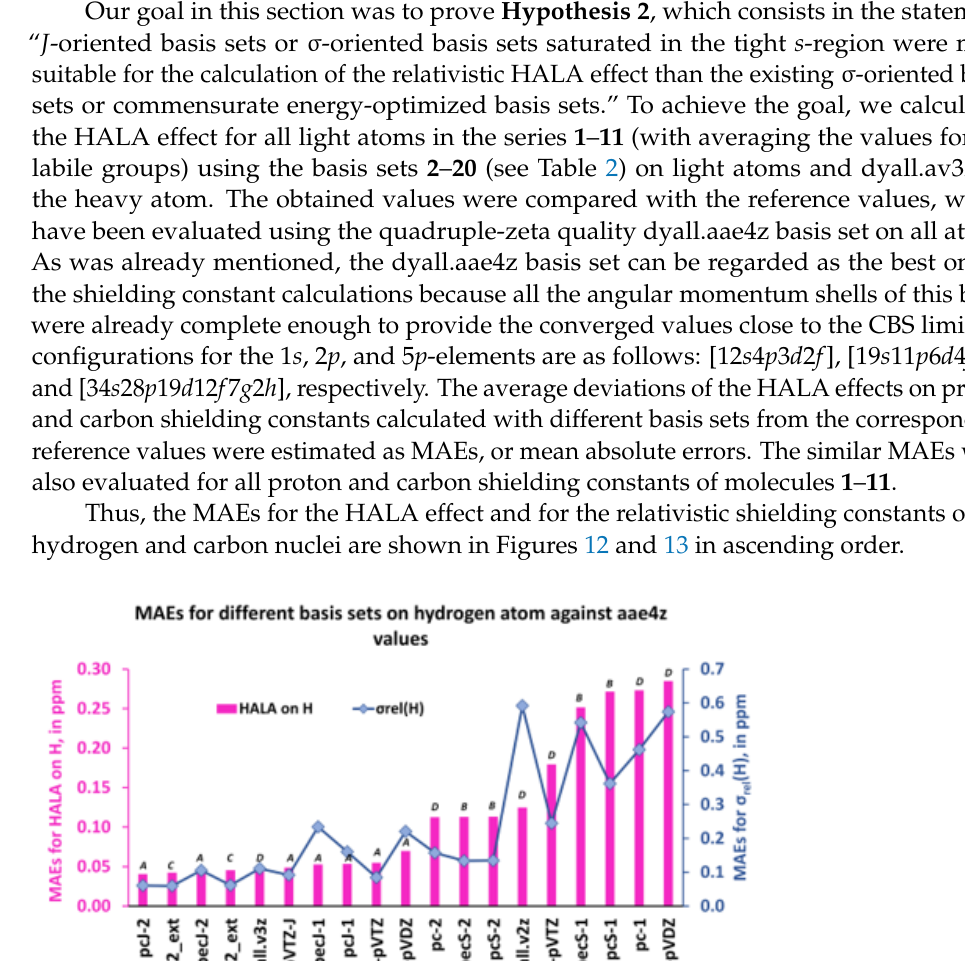
Figure 13. The MAEs for the HALA effect on the carbon shielding constants and that of the carbon shielding constants of molecules 1 – 11 were calculated with different basis sets on light atoms against the values obtained with the dyall.aae4z basis set on all atoms. As one can see from Figures 12 and 13, the first five least MAEs for both the HALA effect and the shielding constants of carbon and hydrogen nuclei are provided by the same group of basis sets of A and C types, though, including one basis set of D type. These basis sets are as follows: pcJ-2 ( A ), pecJ-2 ( A ), pcS-2_ext ( C ), pecS-2_ext ( C ), and dyall.v3z ( D ). The common peculiarity of these basis sets consists in a large number of s -type functions, with a considerable tightness in the largest of them. The dyall.v3z basis set was also on par with the best basis sets of A and C types because it was one of the largest basis sets among the considered ones and provided enough flexibility in all angular spaces, includ- ing the most important tight s -region. The next five basis sets that provided the results of slightly less accuracy for the HALA effect in relation to the reference values were all of the A -type in both cases. The rest of the considered basis sets were all of the B or D types, with four double-zeta quality basis sets, cc-pVDZ ( D -type), pc-1 ( D -type), pcS-1 ( B -type), and pecS-1 ( B -type), providing the largest MAEs. Also, as one can see from Figures 12 and 13, general MAE trends for the proton and carbon shielding constants follow the MAE trends for the corresponding HALA effects, being somewhat different only in particular cases. The same five basis sets, pcJ-2, pecJ-2, pcS-2_ext, pecS-2_ext, and dyall.v3z, provide the best accuracy, but starting with the sixth basis set from the left, there were some discrepancies. In particular, the basis sets of triple-